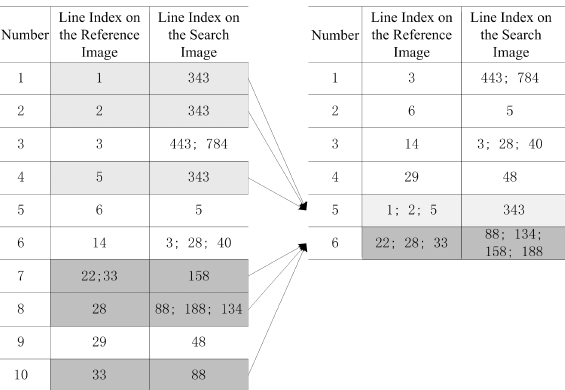
Fig.5 Integrated results of "one-to-many" and “many-to-one” 3.4 Determine the endpoint of corresponding straight line After line matching and integrated, “one-to-one” matching results are obtained. But the length and endpoints of corresponding line are quite different, so the corresponding endpoints are further needed to be determined. In this paper “image-object-image” model was used to determine the endpoints of the corresponding lines. As shown in figure 6, first of all, the corresponding lines were projected to their corresponding object elevation planes on the reference and search images